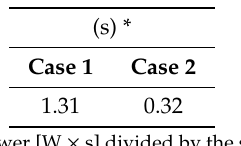
Figure 14. Apparent power of the VSWG (with SG3 installed). Table 3. Released energy from the rotor of the VSWG in case with SG3 installed.